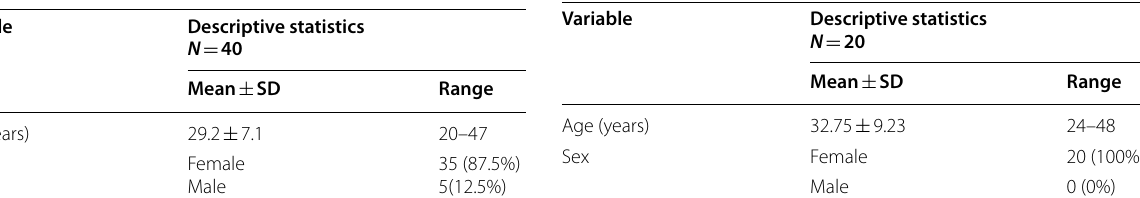
2. A – C (Axial DIR, Flair and T2 sequences, =